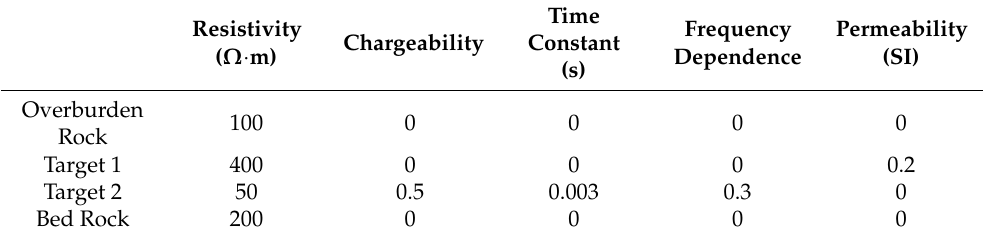
Figure 13. Schematic diagram of model 2.